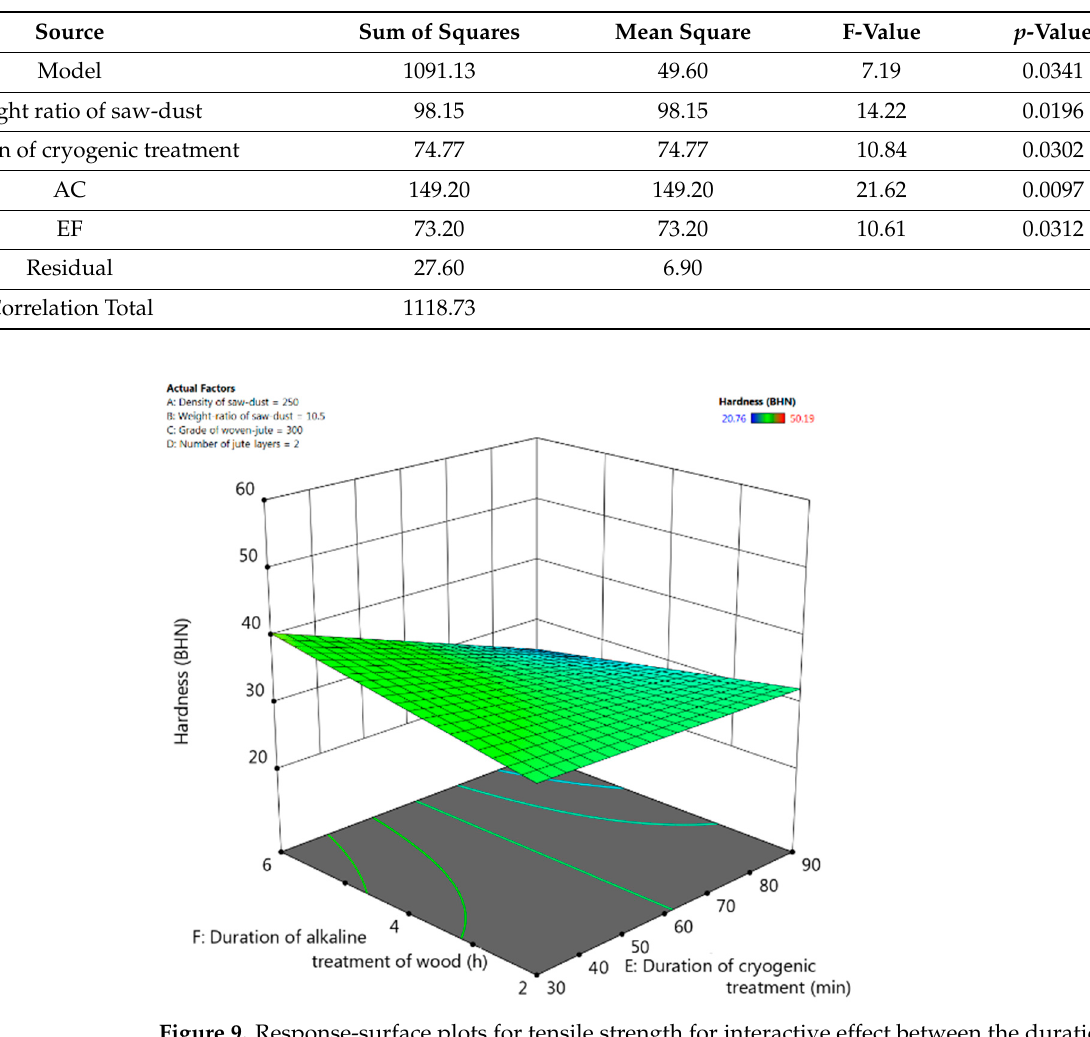
Table 7. Results of ANOVA for hardness including only the significant parameters.